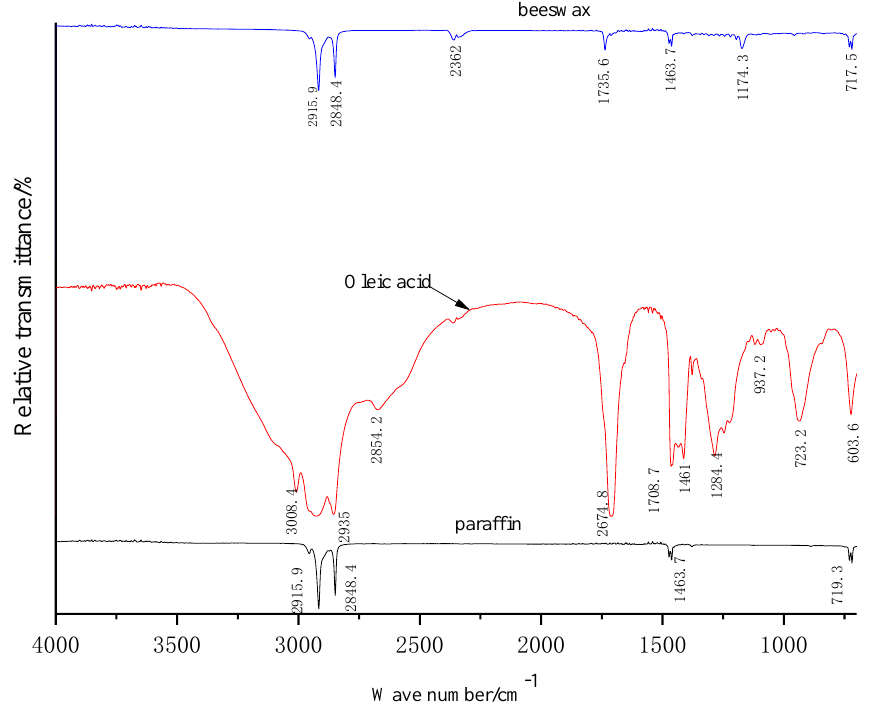
Figure 4. FT-IR analysis of beeswax, oleic acid and paraffin.